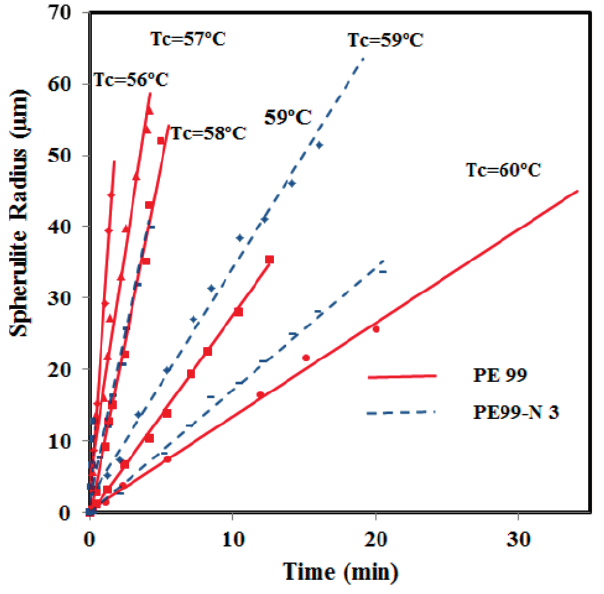
Figure 12. Variation of PE99 ( garnet ) and PE99-N 3 ( blue ) spherulite radii with time for isothermal crystallizations performed at the indicated